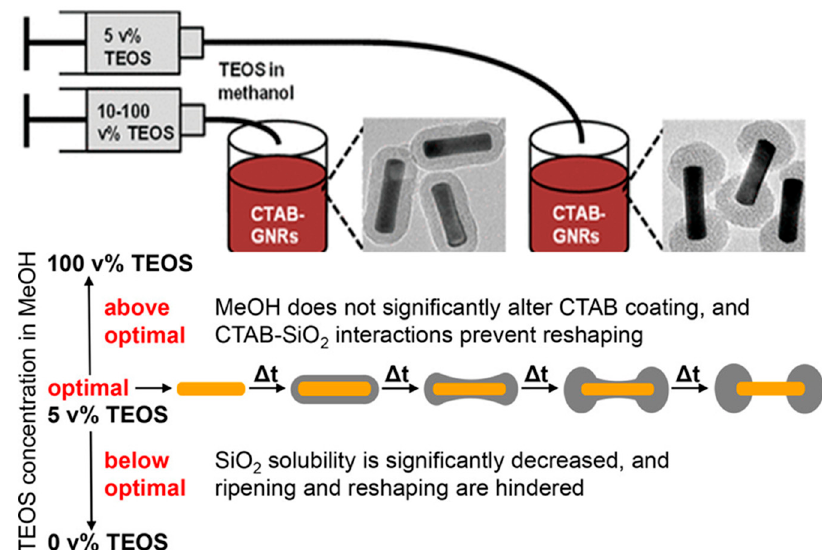
Figure 12. Top: TEM images showing continuous coating and dumbbell-shaped coating of Au NRs. Bottom: Cartoon showing the mechanism proposed by Rowe et al. to explain the influence of methanol on the formation of dumbbell shaped silica coating (from